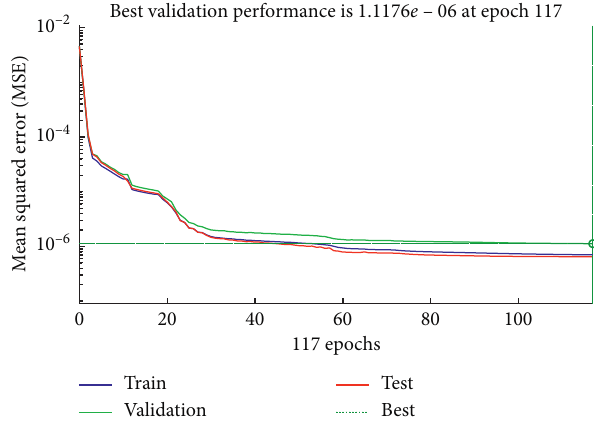
Figure 45: The performance curves of the best network